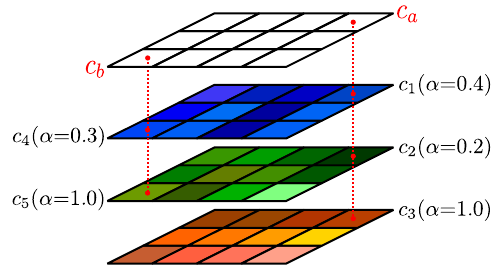
Figure 7: The Layer operator produces several layers that are in- dependently evaluated. Once a terminal symbol is found, i.e. a texture is sampled, we check, if the alpha value of that pixel is already 1 . 0 representing a solid color. In this case, the evalua- tion of the grammar stops and returns the corresponding